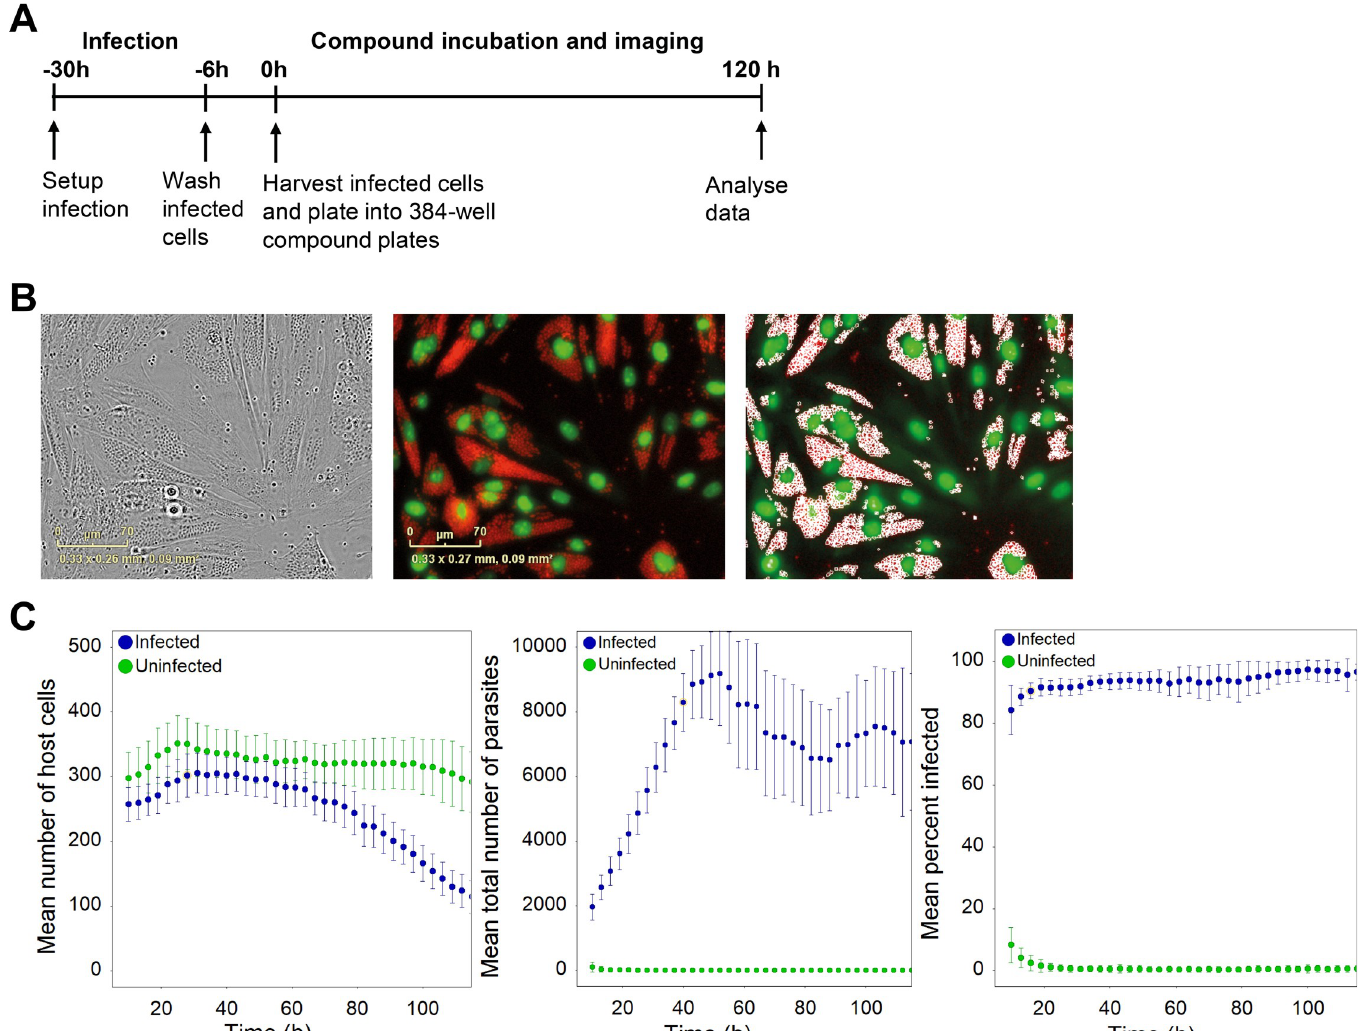
Fig 1. Rate-of-kill assay development: a) Rate-of-kill assay outline; b) Live cell imaging of Tc- X10/7-E2Crimson-infected H9C2-eGFP cells (left panel: brightfield, middle panel: fluorescence image) and image algorithm segmentation segmentation/quantification of E2Crimson-labeled parasites (right panel, segmented parasites are circled white); c) time-course data. Left panel: mean number of Tc- X10/7-E2Crimson-infected H9C2-eGFP cells versus time. Middle panel: total number of intracellular amastigotes detected by the image analysis algorithm per well versus time. Right panel: percent infected host cells versus time. The small number of infected cells seen at early timepoints in the uninfected control is due to image analysis artefacts while the system equilibrates. A representative experiment of 3 biological repeats is shown. Error bars represent standard deviation of 12 technical replicates.